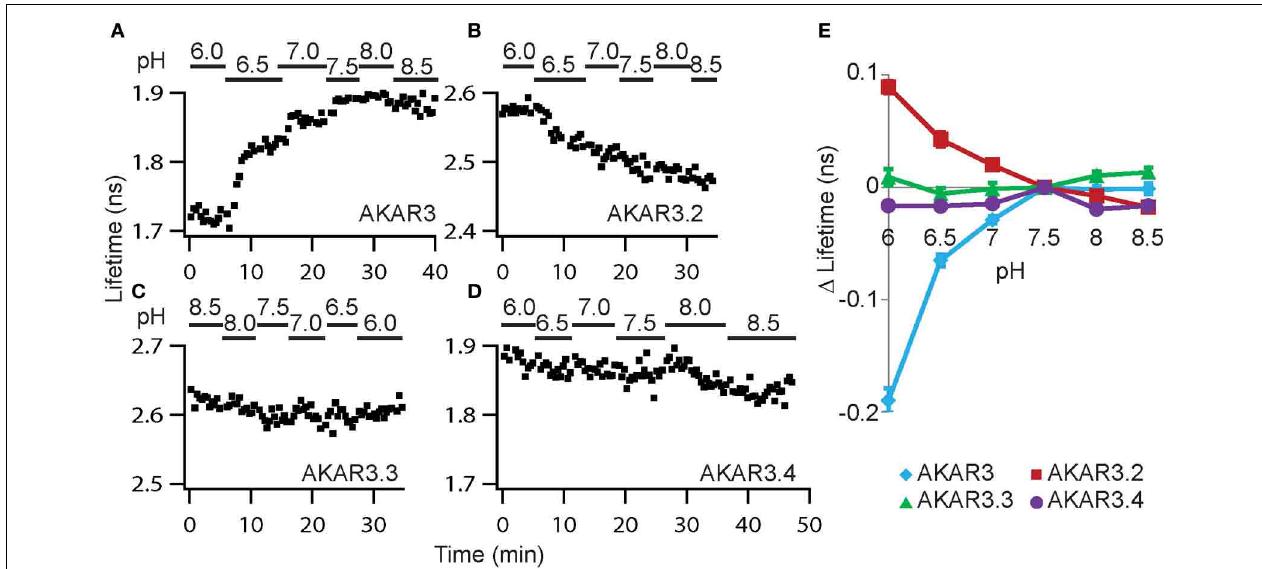
FIGURE 3 | AKAR3.4 shows little sensitivity to pH. (A–D) Example plots showing responses of the four reporters to pH changes. Experiments were performedinHEKcellsatroomtemperatureinthepresenceofnigericin(5 μ M) and the PKA inhibitor H89 (10 μ M). Extracellular solutions buffered to different